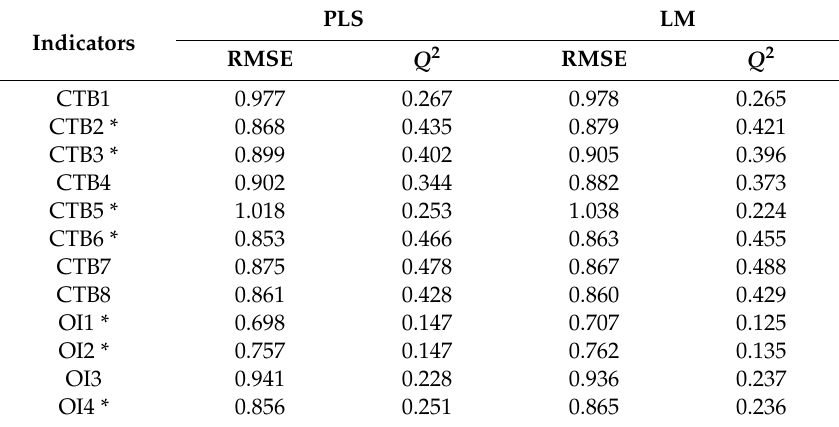
Table 5. PLS prediction summary.